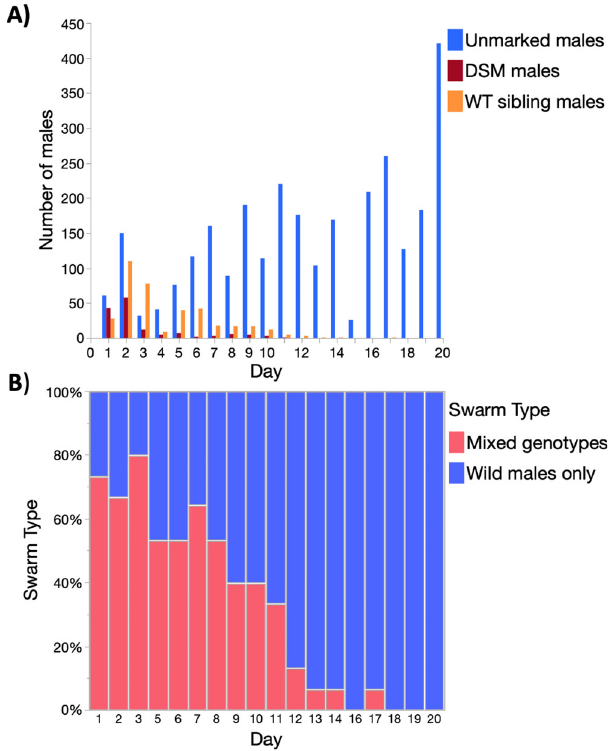
Fig. 4 A and B. Genotypic composition of male swarm recaptures and proportion of mixed versus wild male swarms. A Total number of Ac(DSM)2 males, WT-Ac(DSM)2 sibling and wild males captured each day; B Proportion of mixed swarms and wild male swarms sampled each day. (Ac(DSM)2: Anopheles coluzzii Dominant Sterile Male; WT sibling: Wild type sibling; WT-Ac(DSM)2: Wild Type Anopheles coluzzii Dominant Sterile